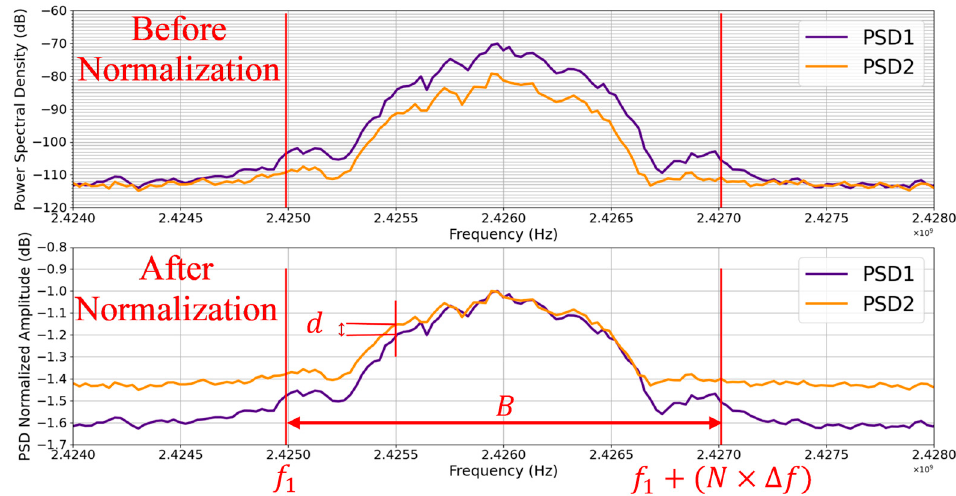
Figure 1. Comparison of different PSDs before and after the normalization. Parameter 𝑑 is fre- quency-dependent and is given by 𝑑 = |𝑃𝑆𝐷 (cid:2869)∗ (𝑓) − 𝑃𝑆𝐷 (cid:2870)∗ (𝑓)| , where * denotes the normalized am- plitude. In this figure, 𝑑 is shown at 𝑓 = 2.4255 GHz as an example.